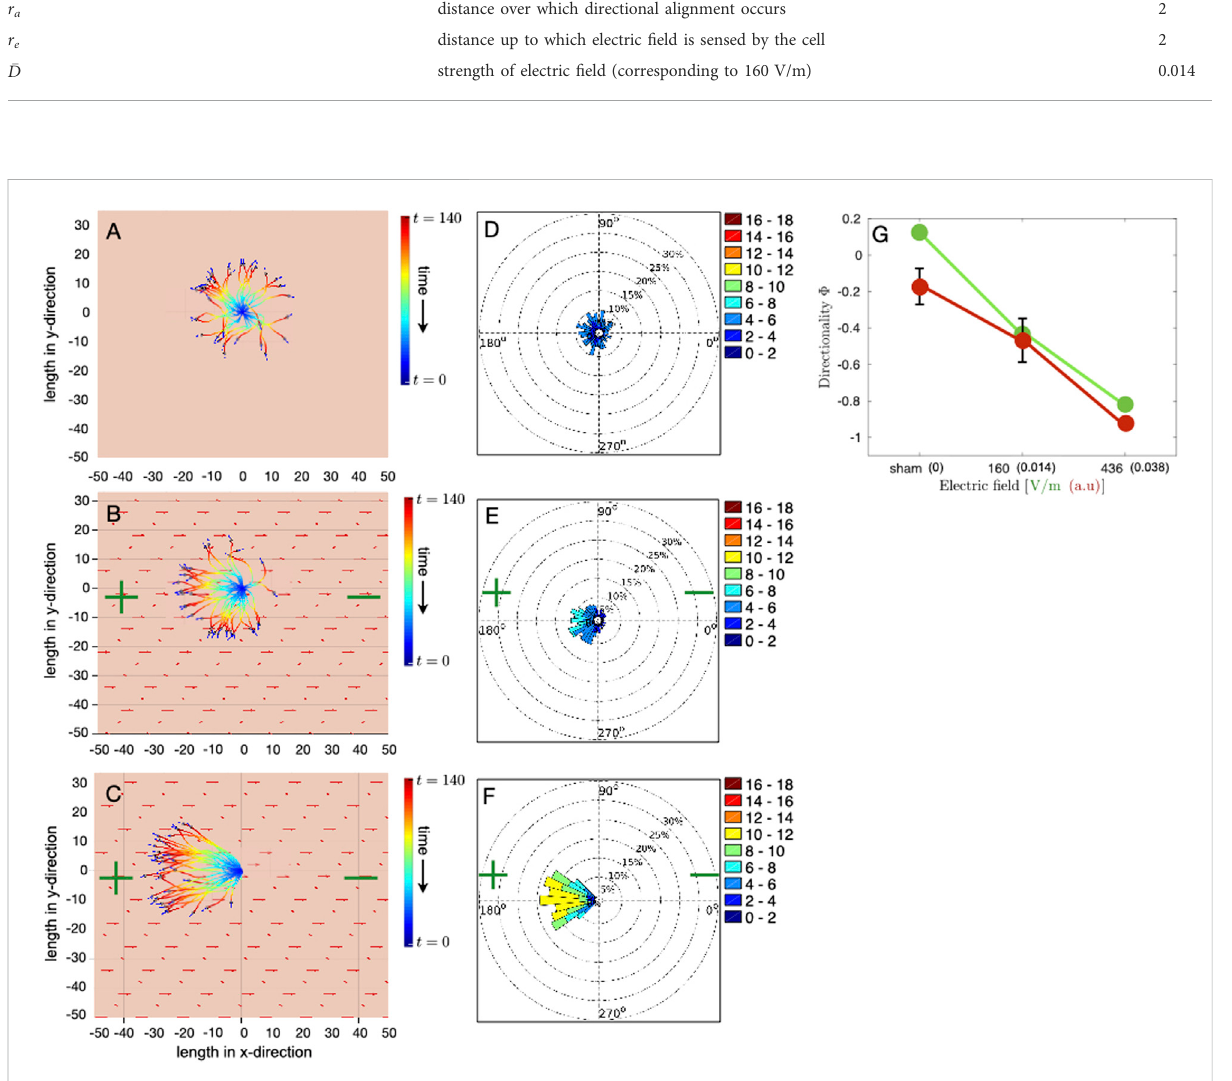
FIGURE 3 SimulationofosteoblastcellmigrationinDCelectrical fi eld.Eachsimulationconsistsof35cells,initiallyrandomlydistributedinacircularregion around the center of the domain of size 50 × 50. Osteoblasts are modeled as light gray colored circular disks of radius R = 1 with initial migration velocities,whicharerandomlyorientedindirection,representedbydarkbluearrows.ThepolarityoftheDCelectric fi eldisdenotedbygreencolored plus and minus symbols, and red arrows represent the electric fi eld vector. The model is simulated for 140 time steps. (A – C) Final positionsand trajectories of individual cells in the case of (A) unstimulated cells and DC electrical stimulation of magnitude 0.014 and 0.038, shown in (B,C) , respectively. Cellpositionsareadjustedsuchthatallthetrajectoriesoriginatefrom x =0and y =0at t =0.Colorgradient ofthetrajectoryrepresents timeevolution,withbluecolorforthestartofthesimulationandredcolorforthelasttimepoint.Adimensionlessvalueof0.038forthemagnitudeof the electric fi eld in simulations corresponds to the maximum electric fi eld strength of 436 V/m in experiments. (D – F) Polar plots show the effective velocity of cell migration, taking into account only the initial and the fi nal time step. (D) shows the polar plot for the unstimulated case, whereas (E,F) present polar plots for 160 V/m and 436 V/m,respectively. Each polar plot isa cumulate of data from 10 separate simulation runs with random initial conditionsandwhereeachsimulationconsistsof35cells. (G) Comparisonofthedirectionalityorderparameter Φ obtainedfromthesimulations(red color fi lled circles connected byred lines) with experiments (green color fi lled circles connected bygreenlines) corresponding to thethree different cases, i.e., no stimulation, stimulation with fi eld strength 160 V/m and 436 V/m, respectively. Each value of directionality obtained from simulations averages ten separate simulation runs. Error bars in simulation data show the standard deviation in Φ